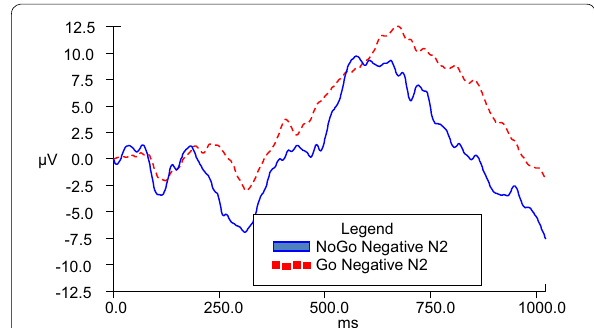
Fig. 4 Representative N2d (NoGo–Go) grand average at scalp